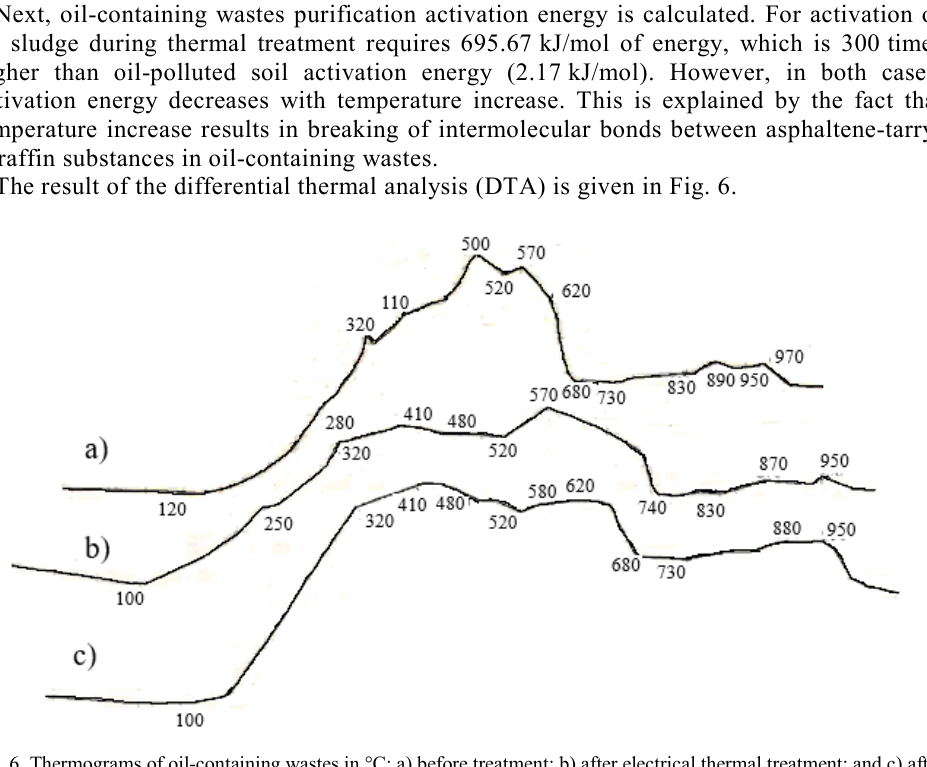
Fig. 6. Thermograms of oil-containing wastes in °С : a) before treatment; b) after electrical thermal treatment; and c) after heating using solar